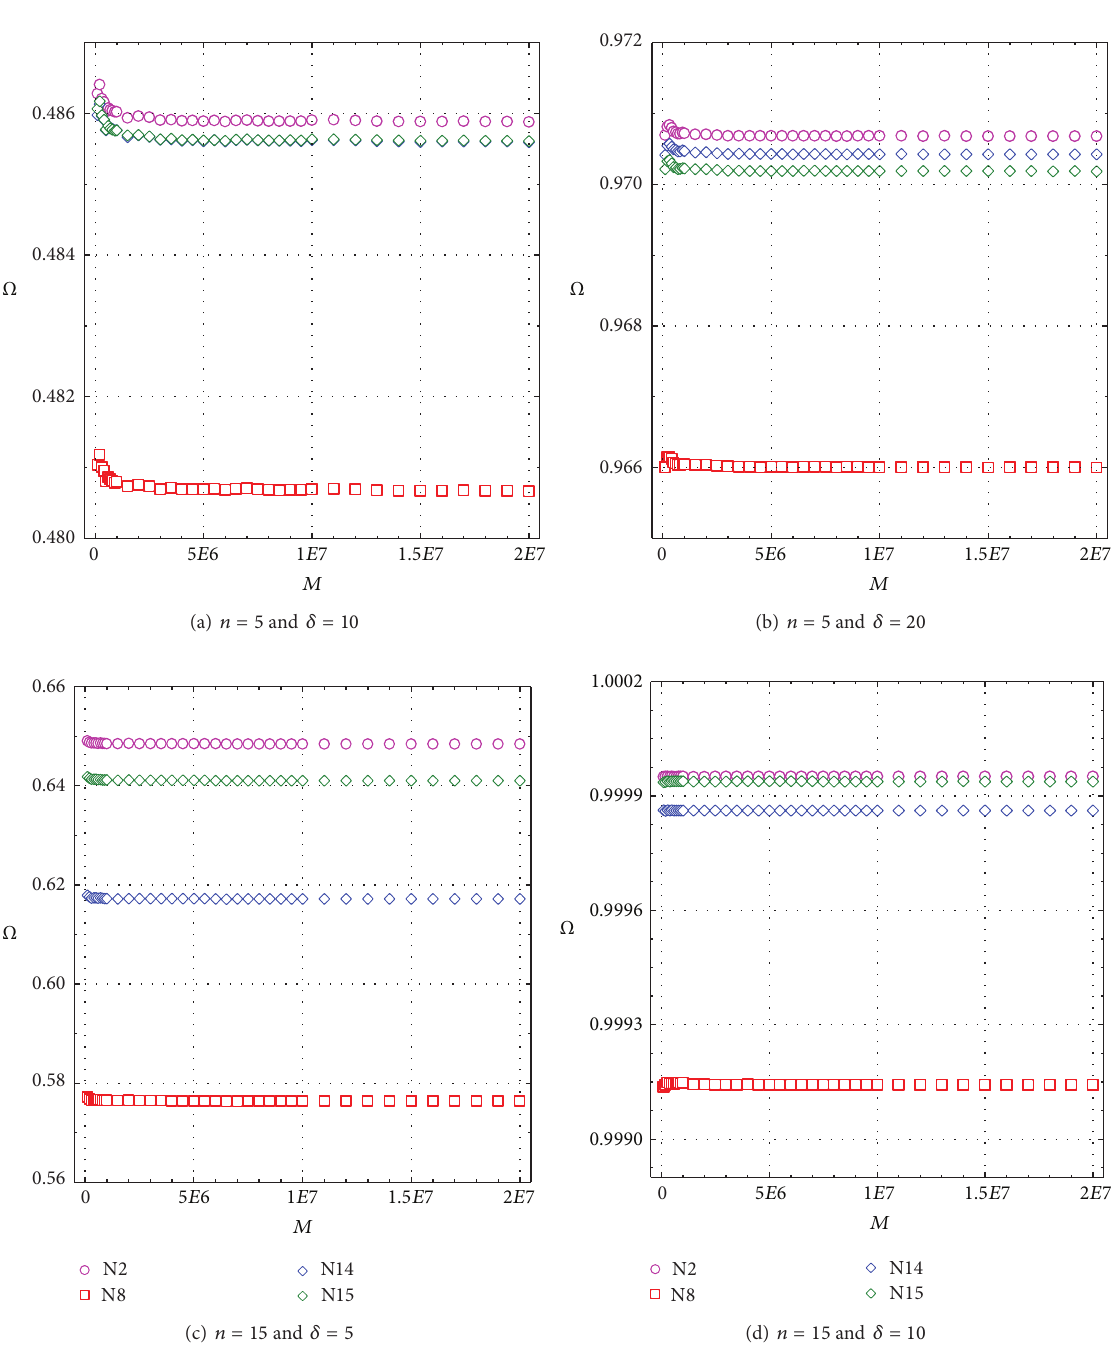
Figure 2: Determination of optimum simulation replication (𝑀) for Power of Test ( Ω ) as a function of replications for all tests N2, N8, N14, and N15; symbols are explained in each figure. (a) Sample size 𝑛 = 5 and contaminant parameter 𝛿 = 10 ; (b) 𝑛 = 5 and 𝛿 = 20 ; (c) 𝑛 = 15 and 𝛿 = 5 ; and (d) 𝑛 = 15 and 𝛿 = 10